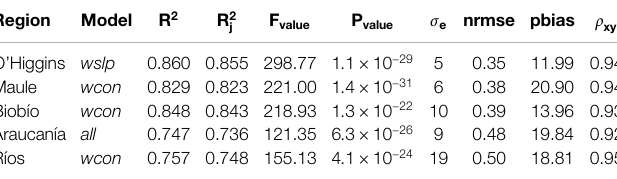
TABLE 3 | Statistical summary of the type of topo-climatic model chosen by the political domain of each region. (wslp), (wcost), (all), (wcon). Region